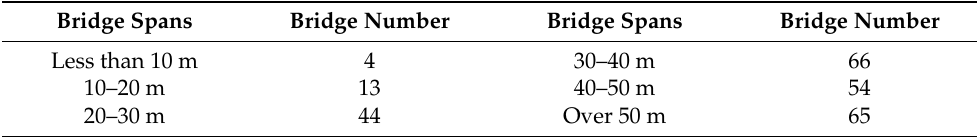
Table 7. Number of bridges and the span length used in the calculation.